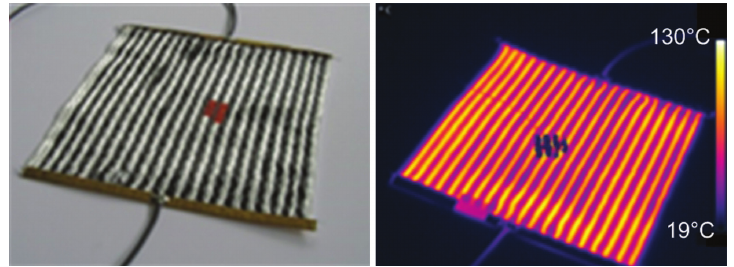
Figure 10 Heating textile (B) by Gerster TechTex (left) and thermal image (right).